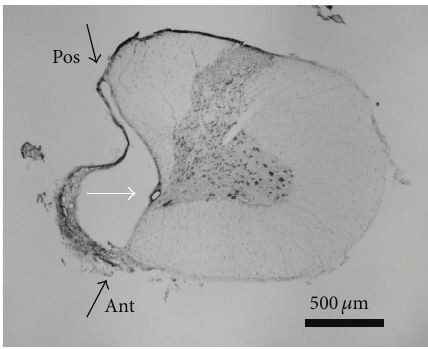
Figure 5: Microphotograph of the spinal cord at lesion level (C3/C4). Scale bar = 500 𝜇 m. Black arrow: spinal cord midline. White arrow: central